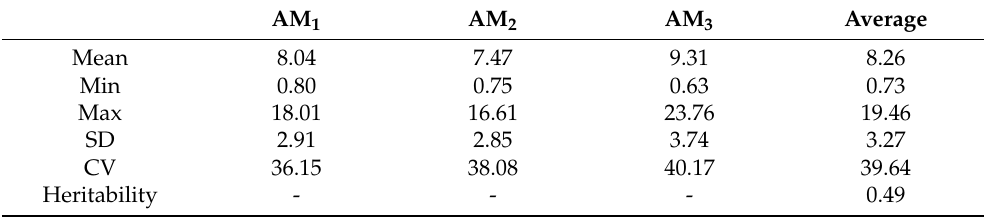
Table 1. F 2:3 families phenotypic summary of inducibility (IND) evaluated in three environments. The Mean, Min, and Max values reflect the percentage of haploids.